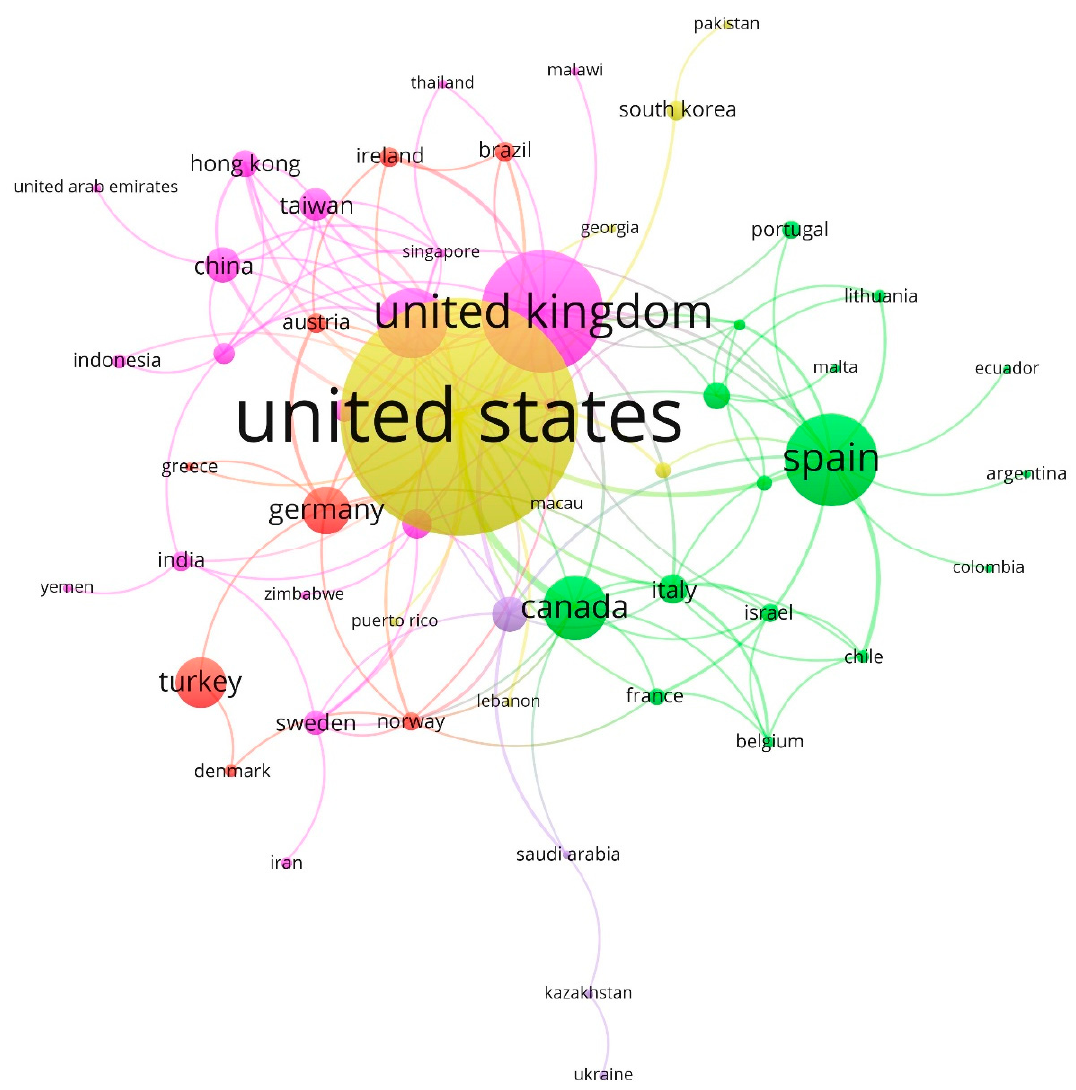
Figure 5. Network of countries/territories based on co-citation method (1917–2020).